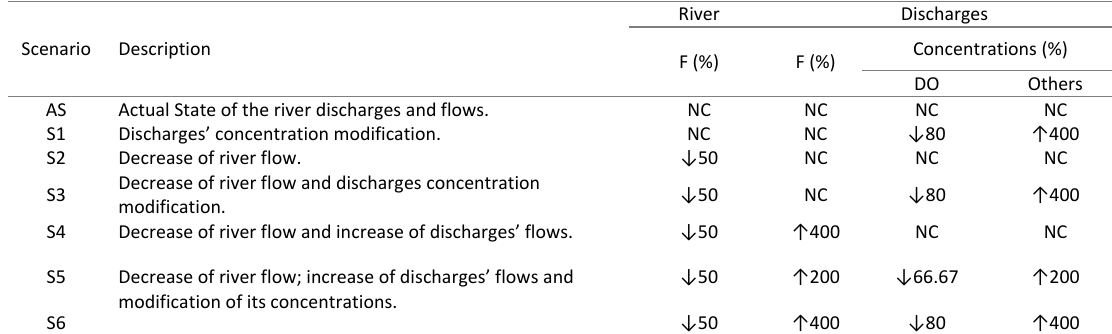
Table 3: Simulation scenarios applied in Sinú River